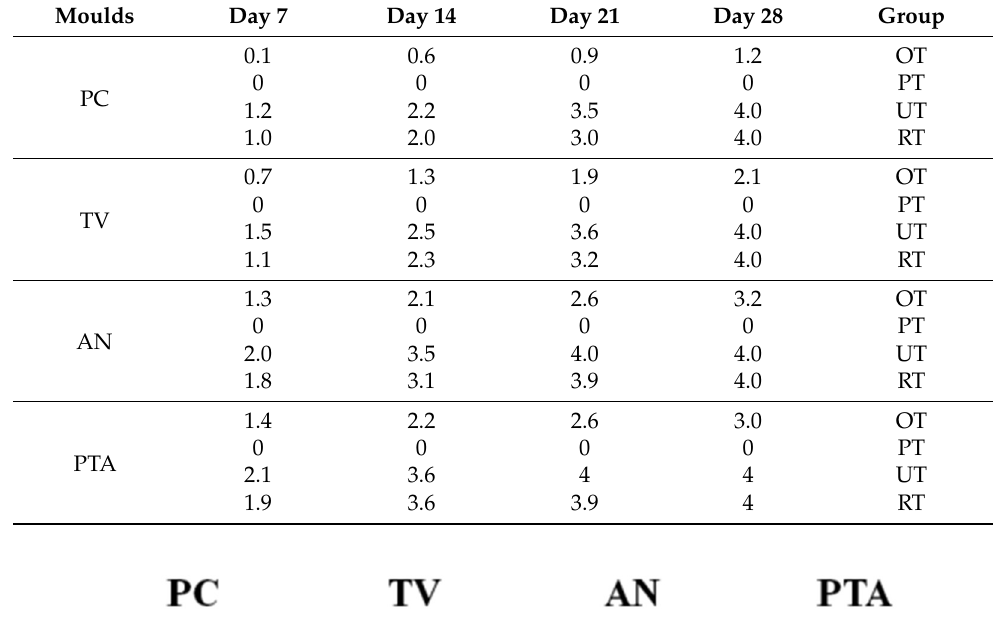
Table 4. Infection grade of bamboo strips during mould control.